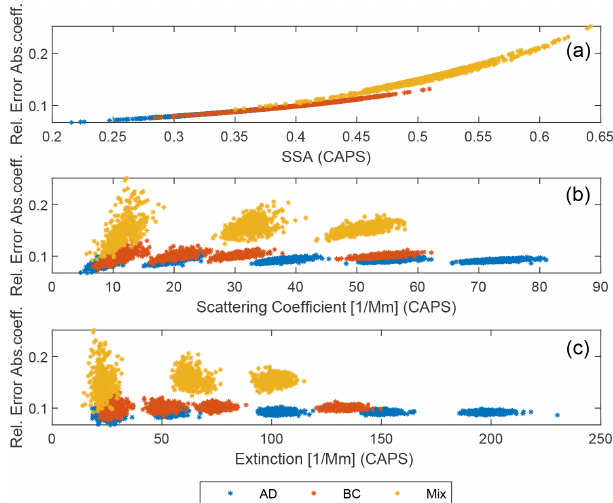
Figure A2. Relative error in the single-scattering albedo derived from PSAP and TSI nephelometer data as a function of the SSA (a) , absorption coefficient (b) and extinction coefficient (c) .